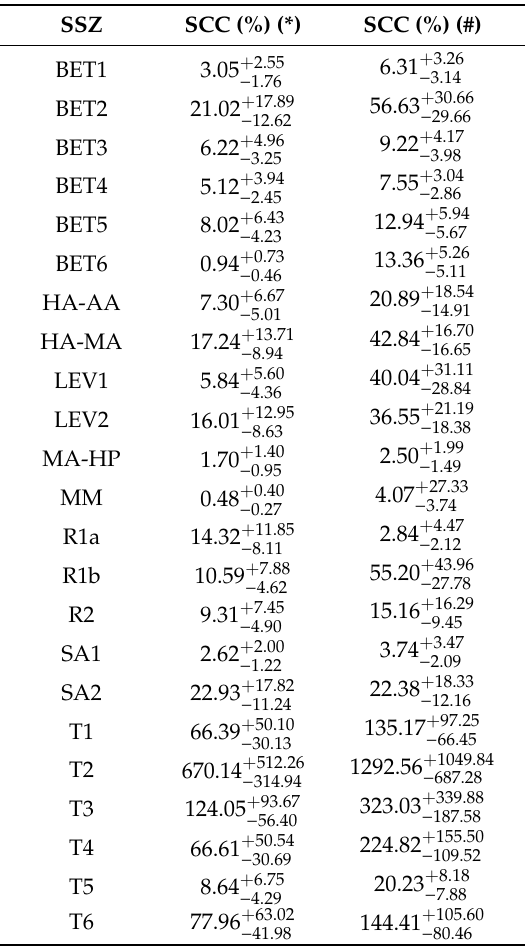
Table 3. Comparison of the seismic coupling coe ffi cient (expressed as a percentage), which takes into account the moment-rates estimated from the (#) truncated cumulative Gutenberg–Richter distribution [16] and the (*) the moment summation [15] approach. Confidence intervals (67%) are also reported. SCC = seismic coupling coe ffi